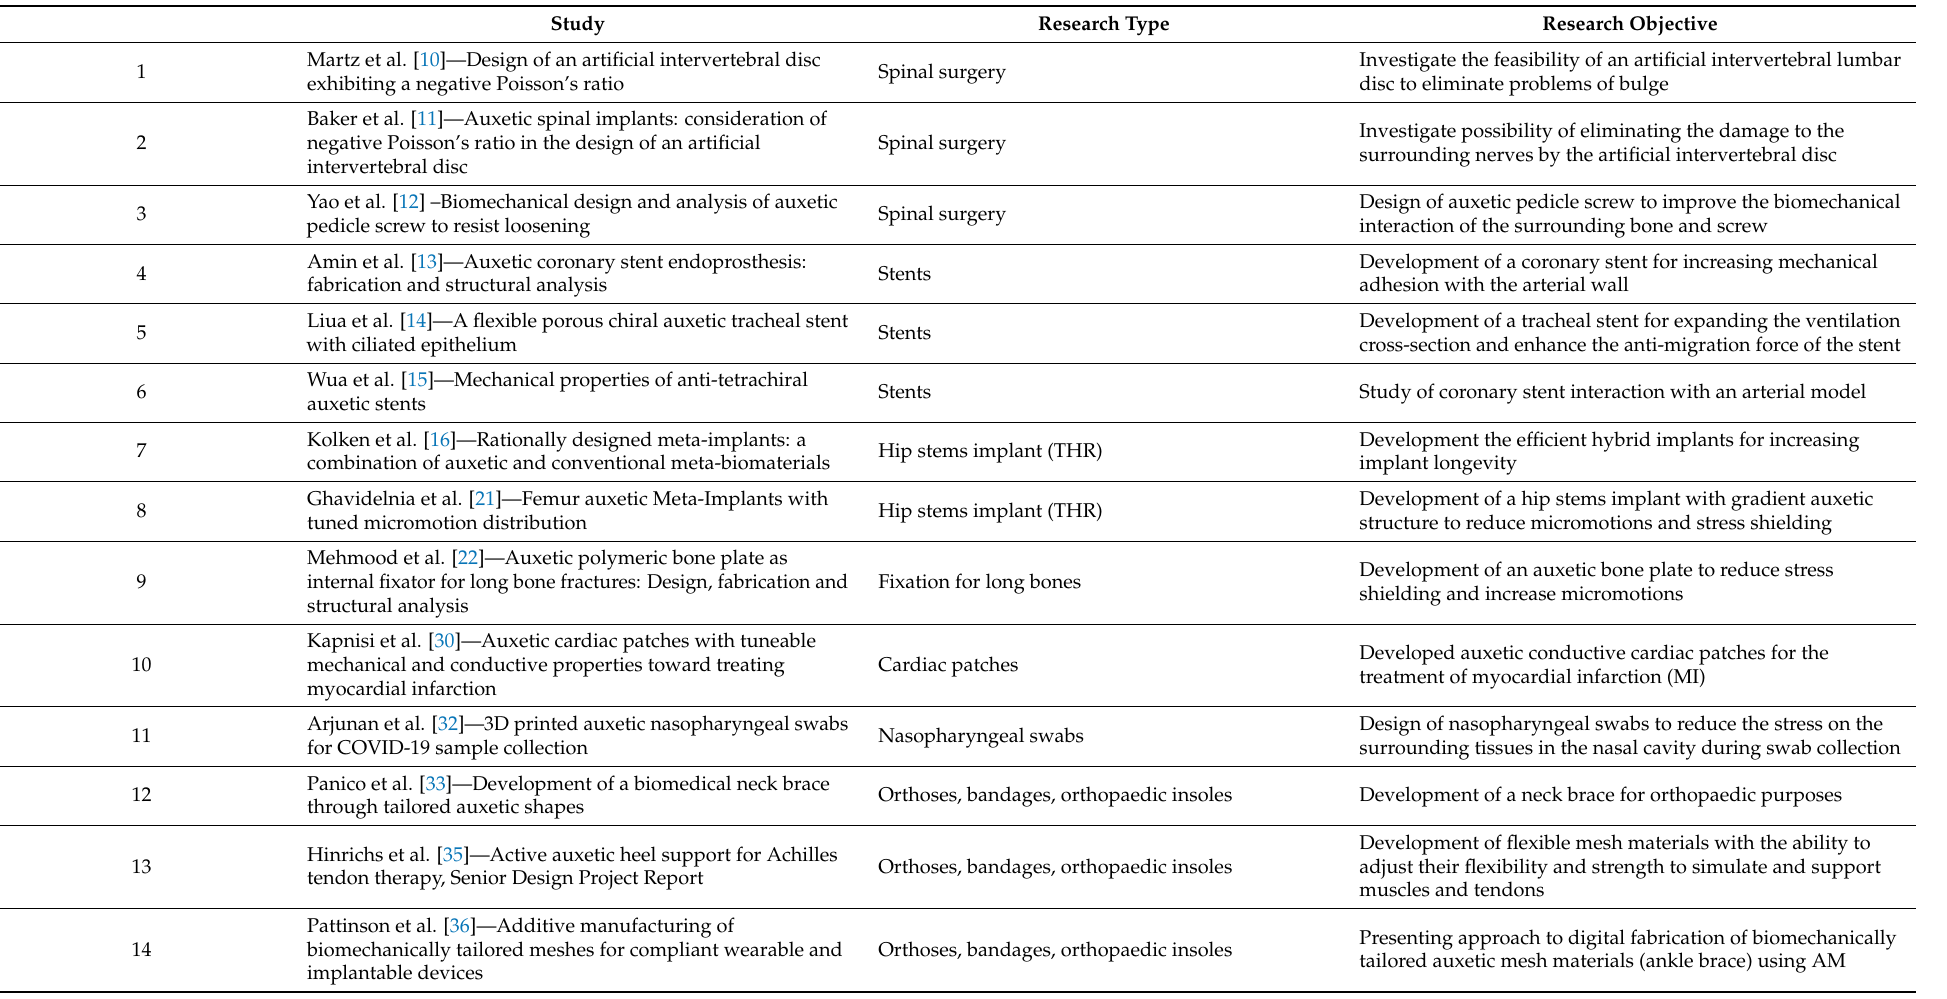
Table A1. Summary of studies dealing with auxetics for biomedical applications and their design and manufacturing